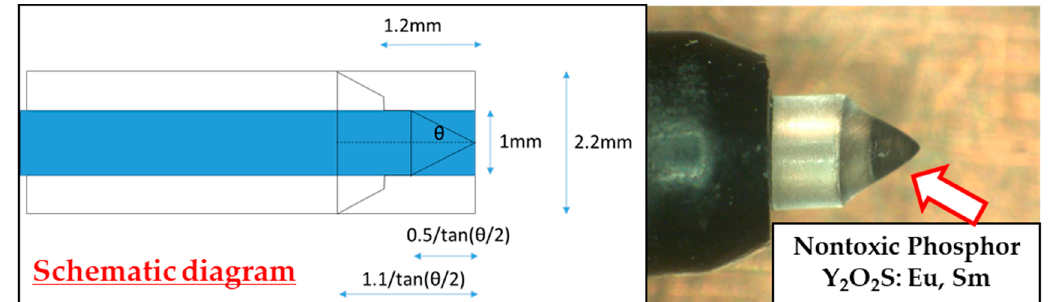
Figure 2. The internal structure of the novel sensor modified to a circular cone sensor.